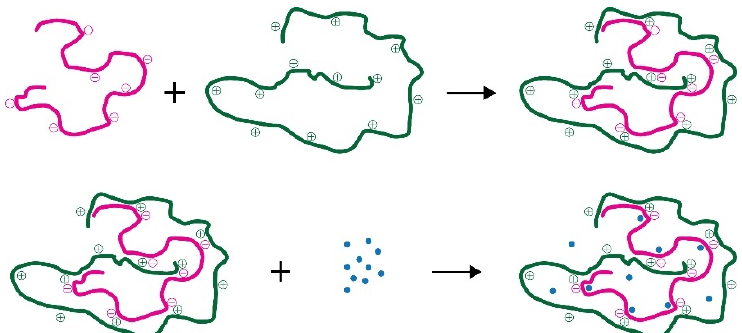
Figure 1. Top panel: The two self-associating biopolymers, namely a polyanionic high-molar-mass hyaluronan (purple) and a polycationic chitosan (green) yield a complex coacervate/polyionic complex hydrogel. Bottom panel: The co-application of an active principle (blue dots) in the formation of a three-component viscous solution, i.e., the material used to construct a composite membrane.